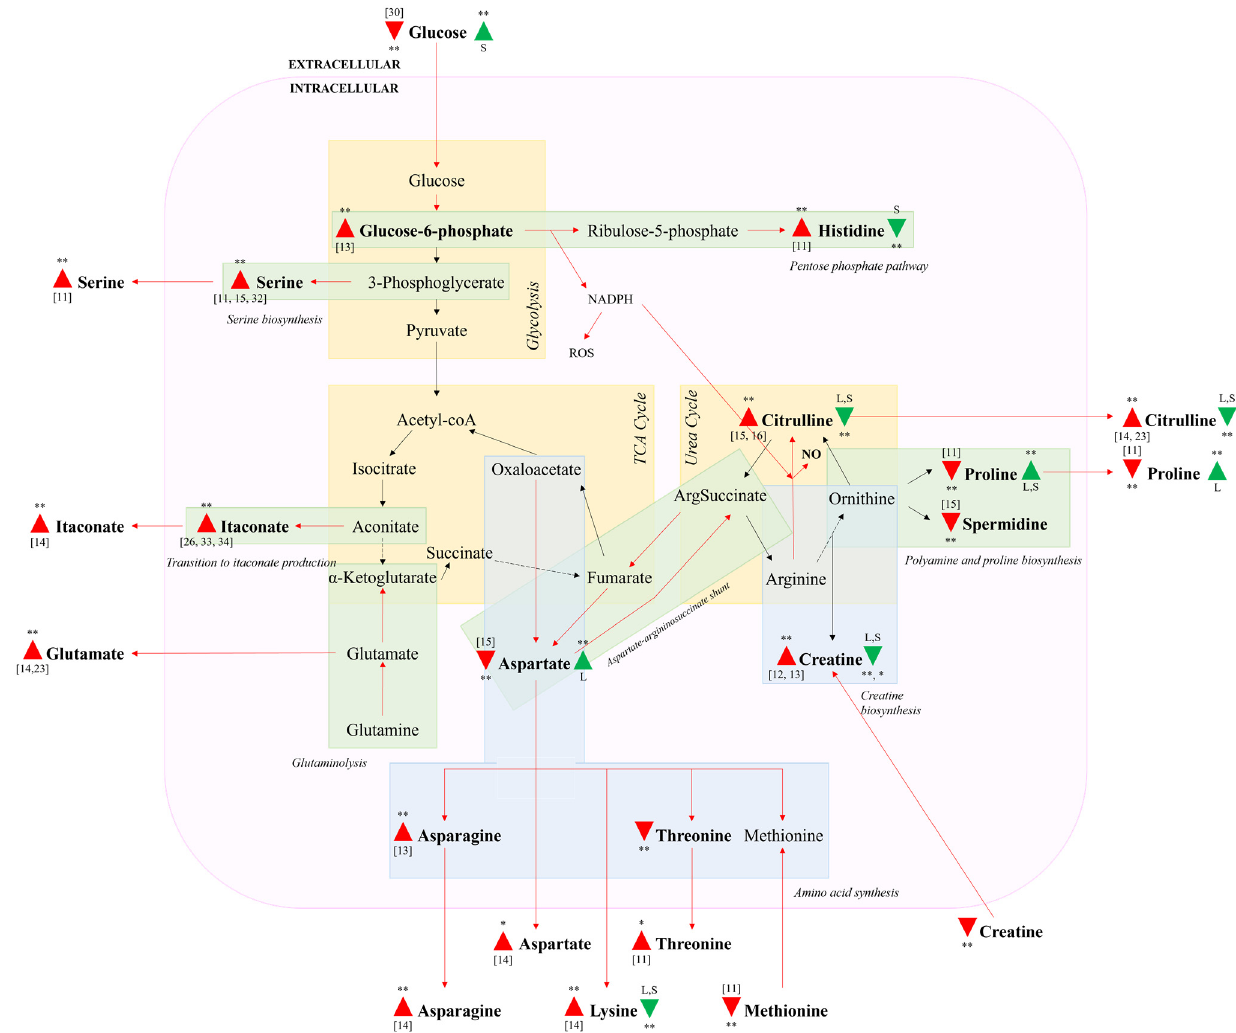
Figure 5. Schematic depiction of metabolic changes associated with LPS activation of RAW 264.7 macrophages and subsequent reversals with celery extracts (CLE and CSE). Compounds listed in bold are significantly differentiated (* and ** indicate p < 0.05 and p < 0.01, respectively). Red triangles indicate up/downregulation due to LPS, with reference numbers included if the finding was previously reported. Green triangles indicate up/downregulation due to celery treatment, with L/S indicating that it was caused by CLE/CSE treatment, respectively. Red arrows indicate upregulated pathways due to LPS, while black arrows indicate the pathways taken by unstimulated cells. Dotted black arrows indicate pathways suppressed by